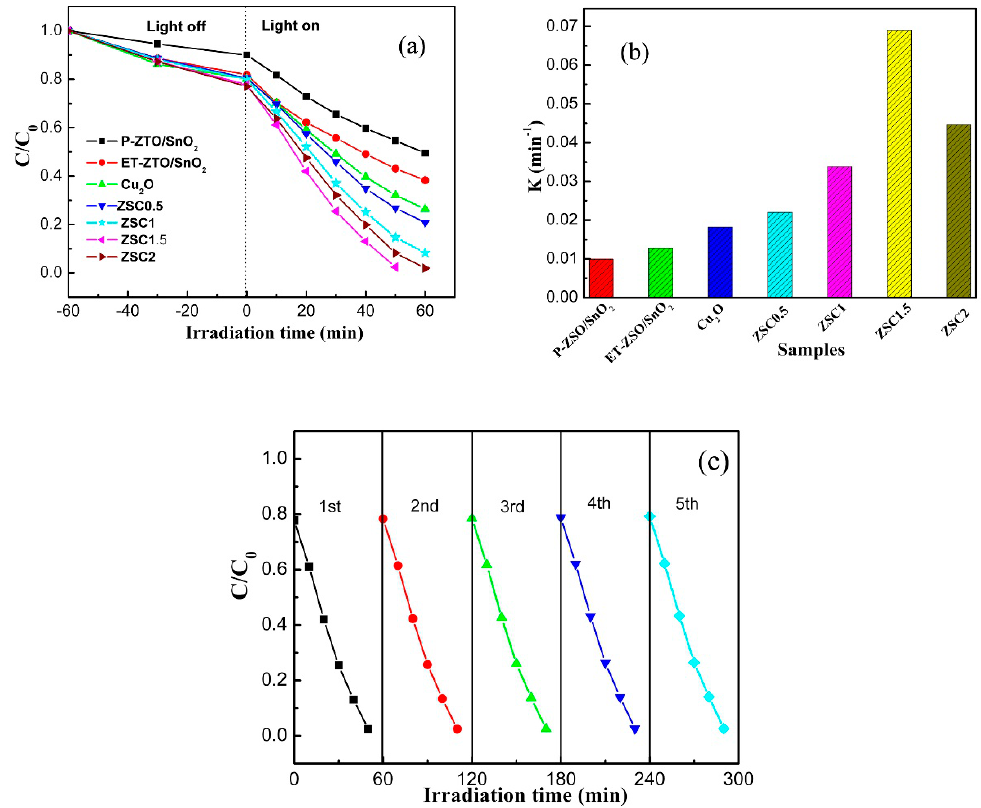
Figure 7. Photocatalytic degradation curves ( a ) and corresponding reaction kinetic constant curves ( b ) of P-ZSO/SnO 2 , ET-ZSO/SnO 2 , and ZSC hybrids with different weight ratios, ( c ) cycling runs in the photocatalytic degradation of RhB in the presence of ZSC1.5 sample.